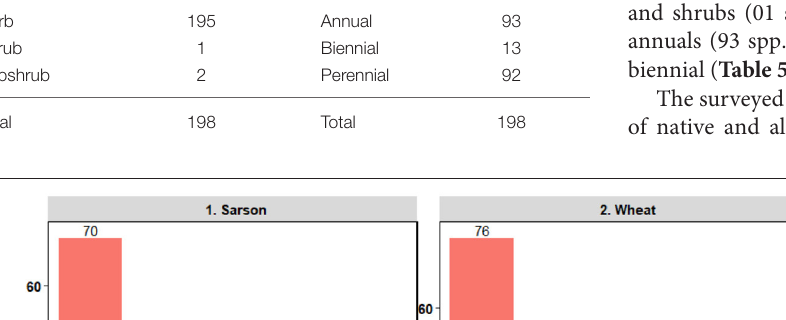
Frontiers in Agronomy |